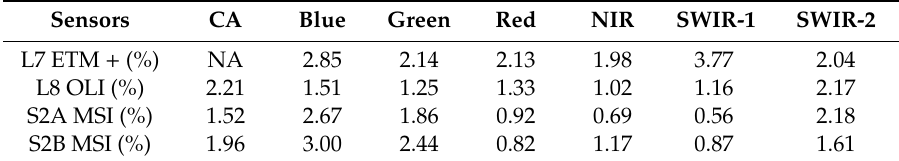
Table 9. Accuracy between measured and Sudan 1 simulated values.